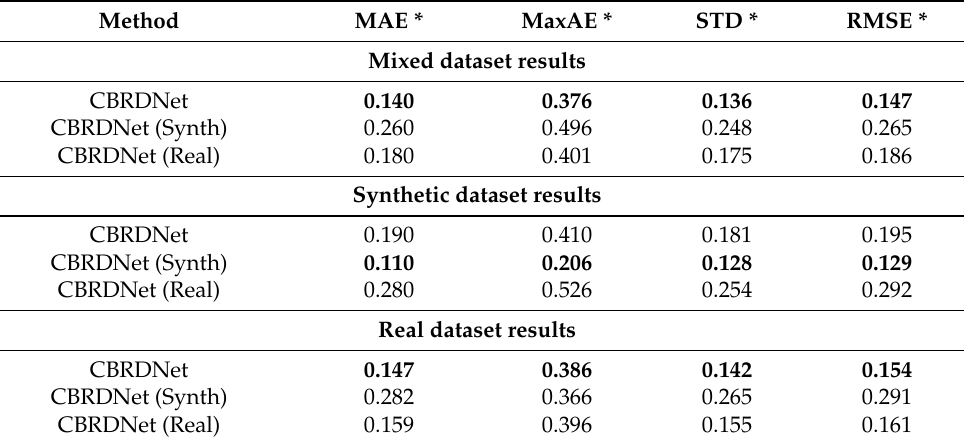
Table 4. Comparative results of training data ablation studies. MAE = mean absolute error; MaxAE = maximum absolute error; STD = standard deviation of the absolute error; RMSE = root mean. (Synth) = trained on synthetic dataset; (Real) = trained on real dataset squared error. Best results presented in bold font. Method MAE